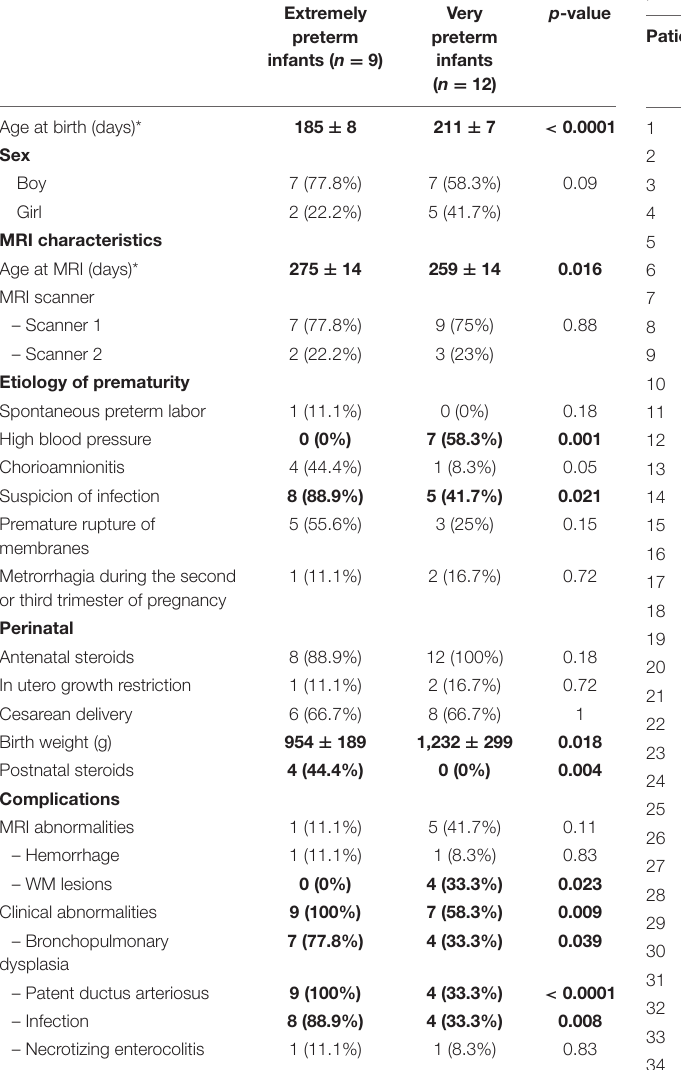
TABLE 4 | Subject characteristics for perfusion analysis. TABLE 5 | Distribution of morphologic, diffusion and ASL perfusion sequences performed for each included preterm